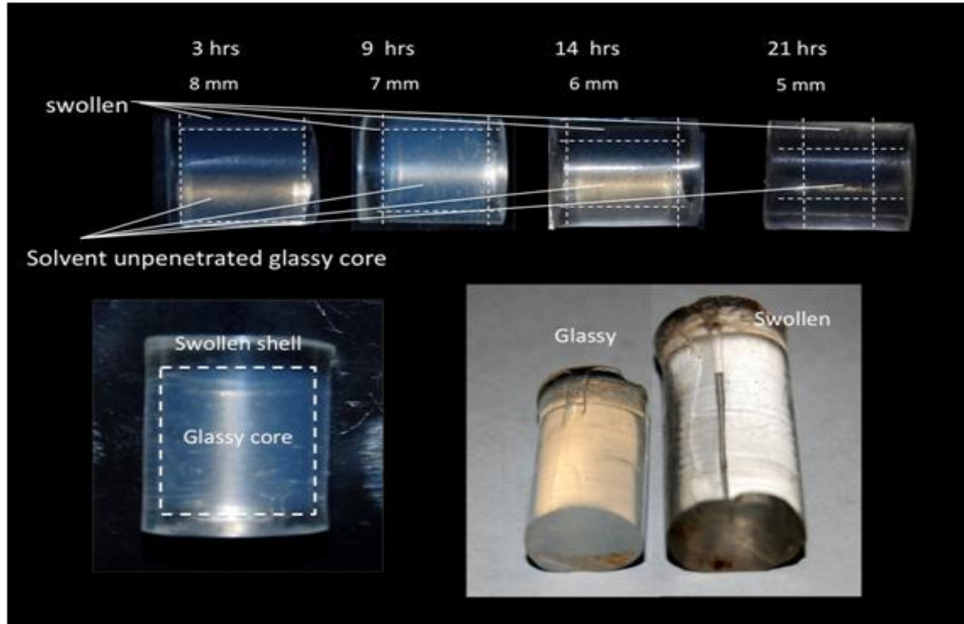
Figure 1. Swelling behavior of a hybrid hydrophilic nanocomposite in water [5]: Volumetric swelling from glassy to rubber states (Lower right), clear front between the internal unpenetrated glassy core and the water-swollen outer shell (Lower left), the front progressively advances at increasingly reducing the glassy core thickness (Upper part of the